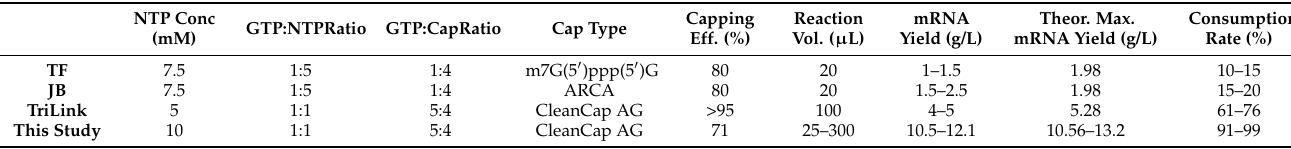
Table 7. Comparison of different kit manufacturers with this study